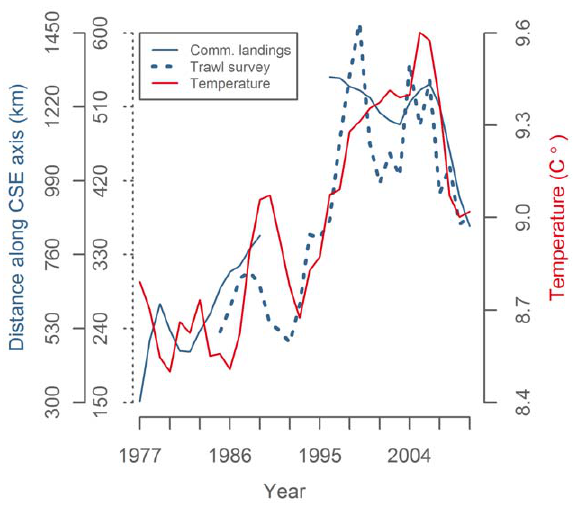
Figure 9. Mackerel distribution and temperature trends (3y rm). Position of 50% cumulative landings in Q4 and in survey CPUE along the continental shelf edge axis (blue) and temperature around the shelf edge in the Northern North Sea from off Shetland Is. to the western edge of the Norwegian trench in November–January (red).